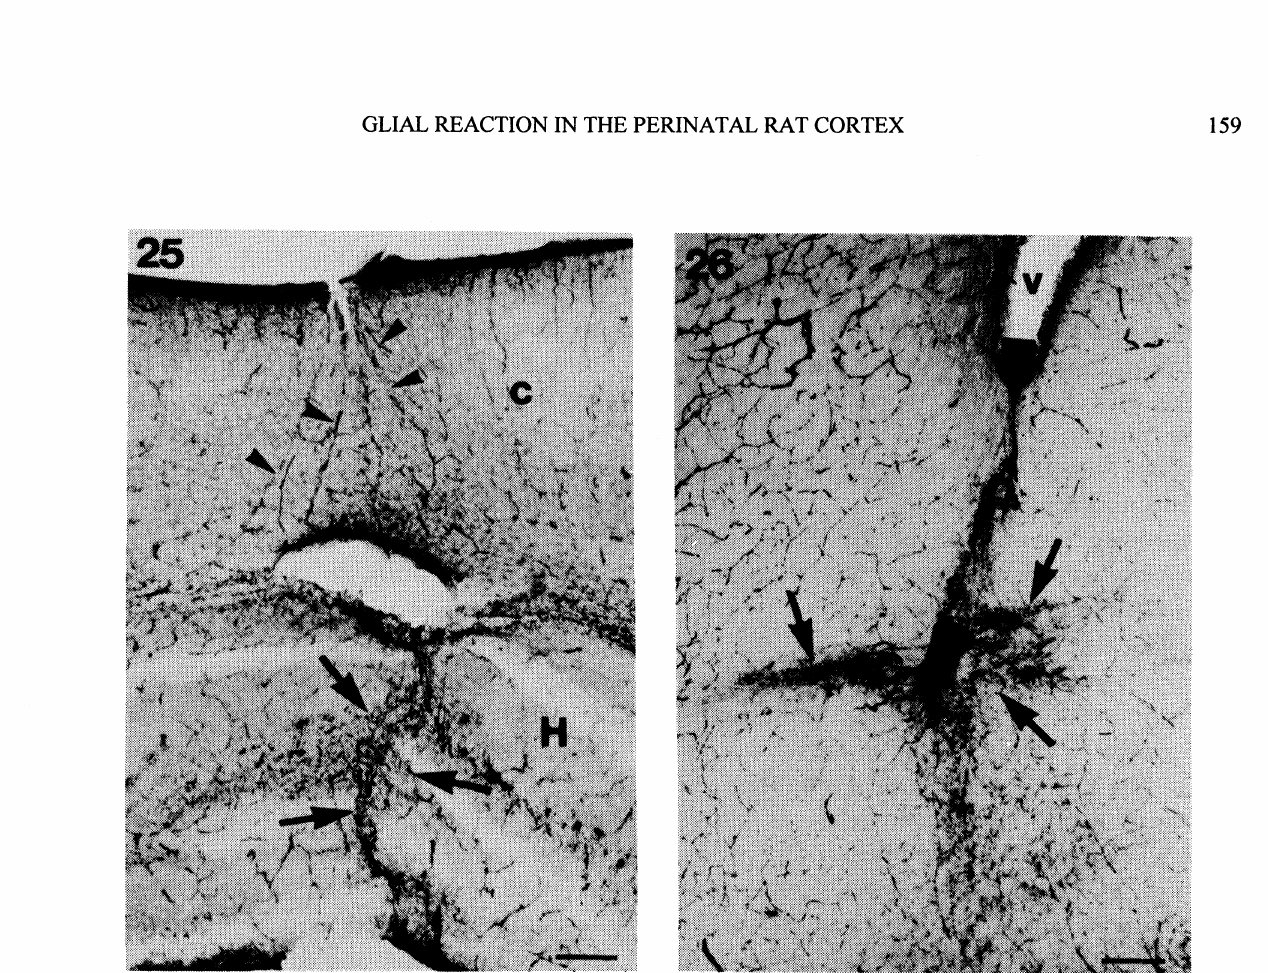
Figs. 25--26: GFAP immunostaining of light-type P0 lesions. (25) Post-op d-4. In the cortex (c) only the modified arrangement of blood vessels (arrowheads) indicates the position of the lesion. Reactive glia (arrows) are found only in the hippocampus (H), but not in the cortex. Bar 400 I.tm. (26) Post-op d-4. A subcortical detail of the telencephalon, near the lateral ventricle (v). Glial reaction (arrows) has developed along the lesion (thick arrow), and has spread along the anterior commissure (AC) but not in the surrounding tissue. The contralateral part of the AC was only poorly immuno- positive. Bar 200